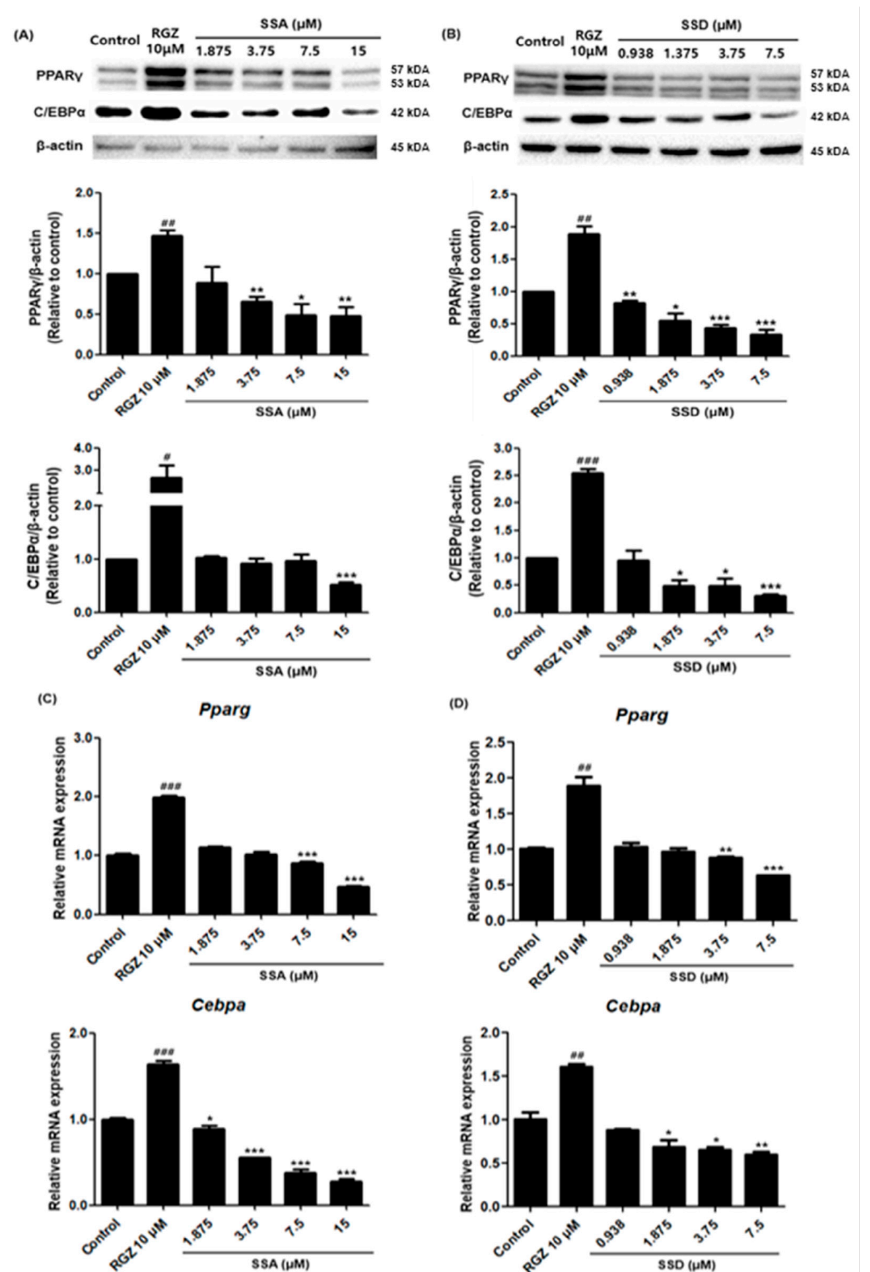
Figure 3. Effect of SSA and SSD on the protein and mRNA expression levels of PPAR γ and C/EBP α in 3T3-L1 cells. Cells were seeded in a 6-well plate and stimulated to differentiate with DIM, DPM and PDM in the presence or absence of SSA and SSD (0.938, 1.875, 3.75, 7.5 and 15 µ M) for 8 days. ( A , B ) The protein levels of PPAR γ and C/EBP α were analyzed using Western blot with specific antibodies. ( C , D ) Relative mRNA expression levels of Pparg and Cebpa were measured by quantitative real-time PCR. Results are shown as a relative of control (0.5% DMSO) values and RGZ (rosiglitazone) was used as a positive control for these experiments. The β -actin was used as a loading control and the Gapdh was used as a house keeping gene. Target gene mRNA levels were normalized to Gapdh using the 2- ∆∆ Ct method. Data are mean ± standard error of the mean (SEM) of three independent experiments. * p < 0.05, ** p < 0.01, *** p < 0.001, # p < 0.05, ## p < 0.01, ### p < 0.001 compared with control, #: increased compared to control, *: decreased compared to